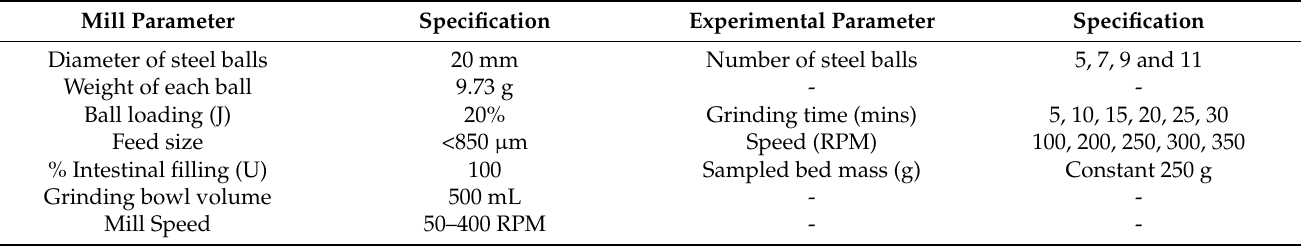
Table 4. Planetary mill test conditions and varied parameters used in the